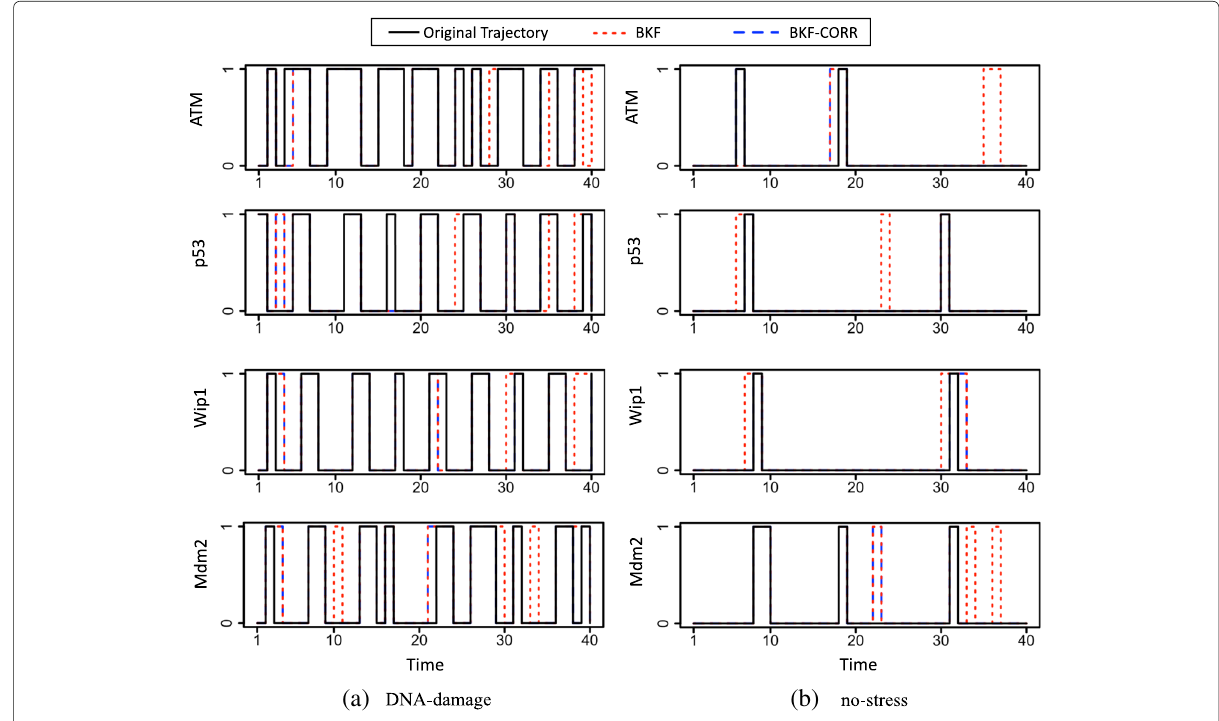
Fig. 6 Original and estimated state trajectories for a no-stress and b DNA-damage